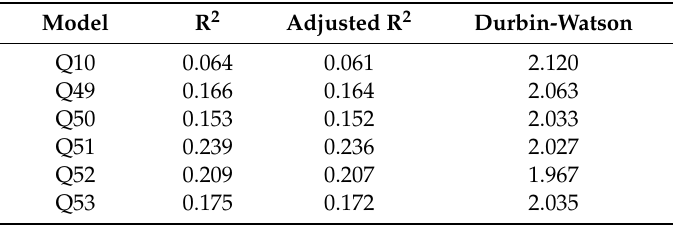
Table 2. Summary of the multiple regression analysis for the first hypothesis.